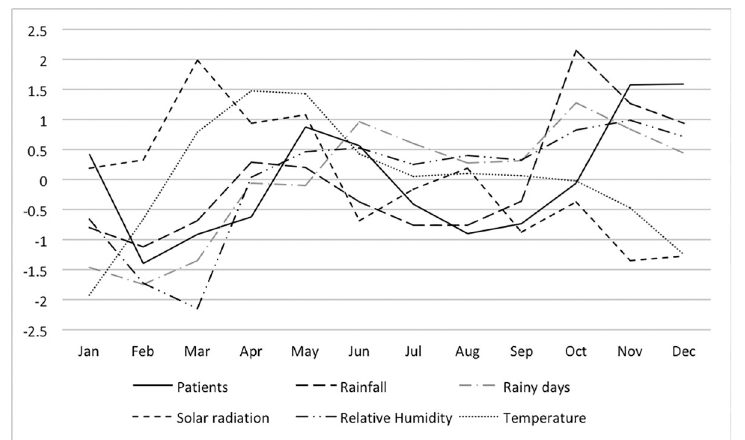
Fig 5. Monthly distribution of the standardized incidence of leptospirosis cases and meteorological parameters in the highlands of Sri Lanka.